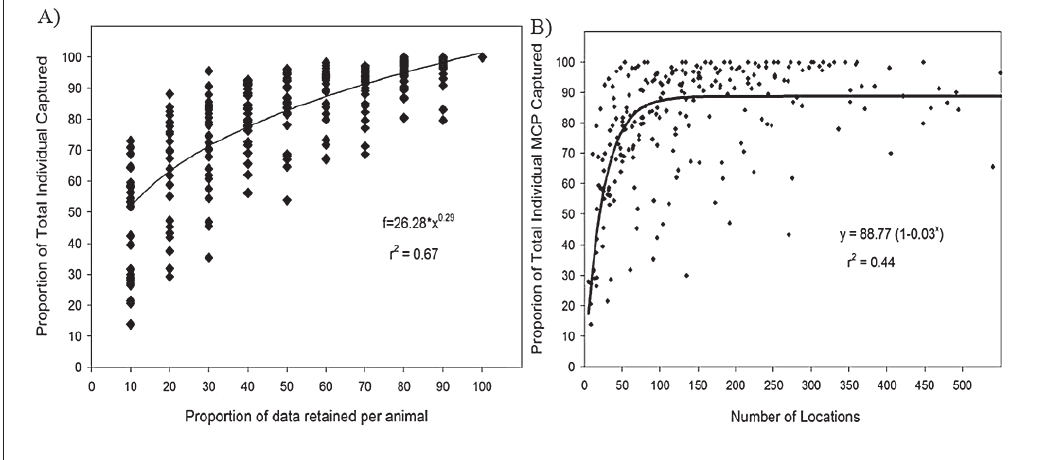
Fig. 2. Relationship between the proportion of individual 100% MCP range captured and a) the proportion of locations used per individual and b) the number of locations